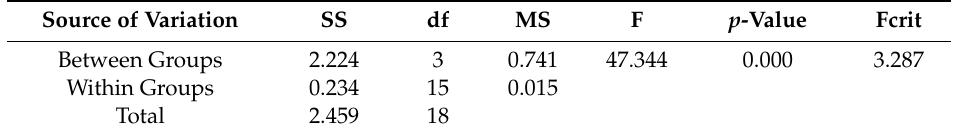
Table 4. ANOVA of energy at break and b. post hoc analysis.